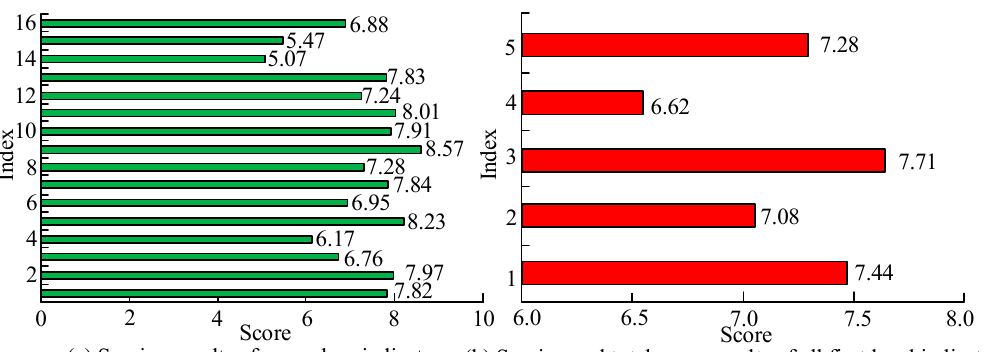
(b) Scoring and total score results of all first level Figure 6. Scoring results of each index of parametric design based on GIS. Figure 6. Scoring results of each index of parametric design based on GIS.